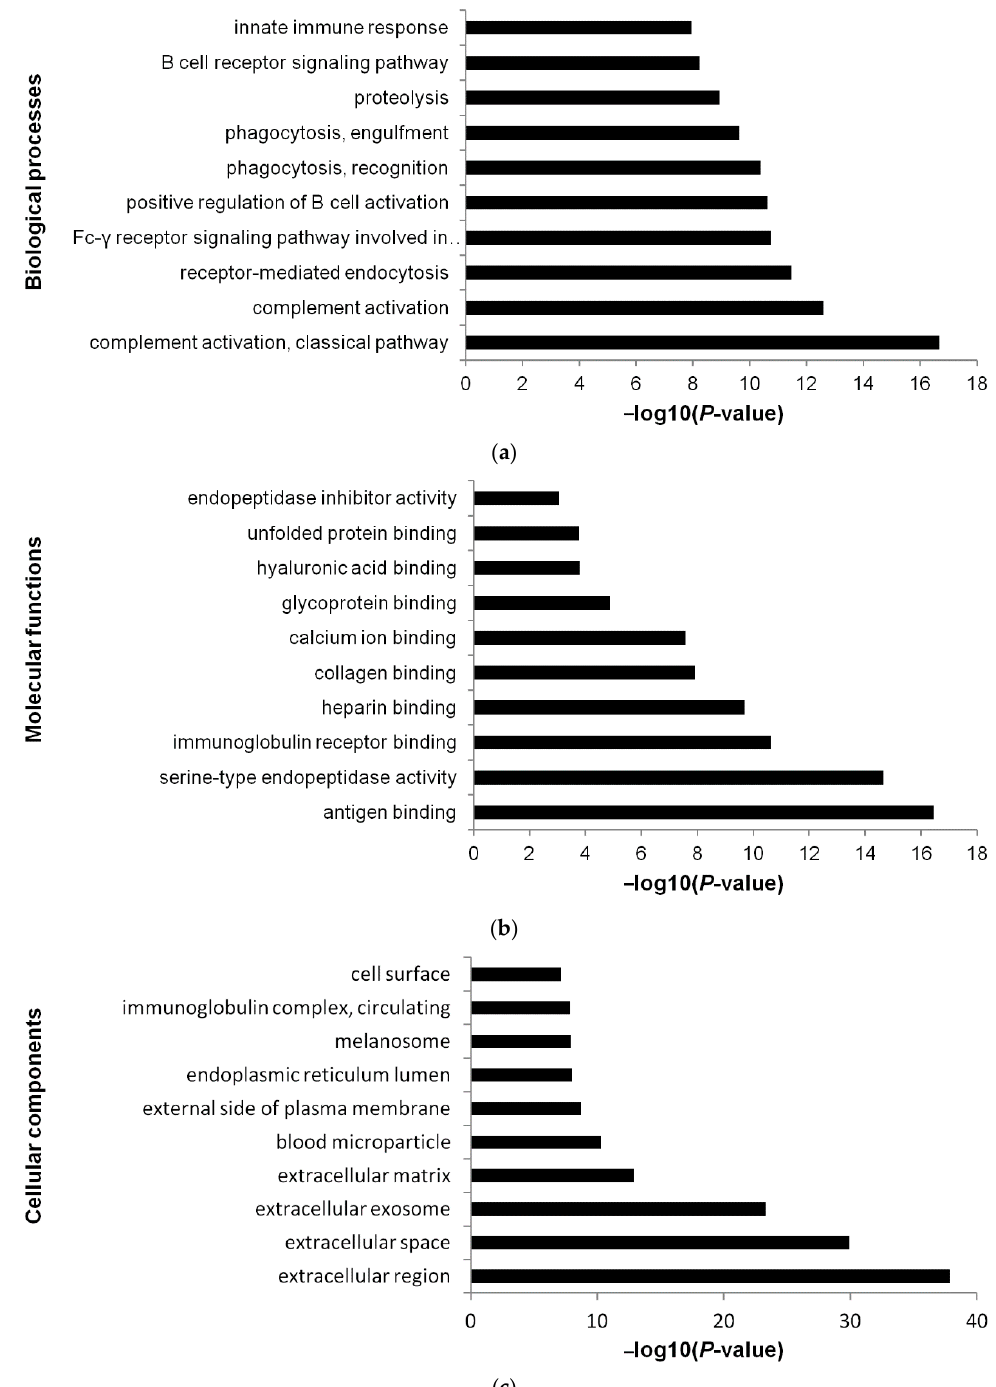
Figure 9. Top 10 most significant (Benjamini-corrected p < 0.01) biological processes ( a ), molecular functions ( b ), and cellular components ( c ) associated with plasma EV proteins of non-relapsed HL according to DAVID Bioinformatics Resources interrogated with the proteins identified LC–MS/MS after eliminating the proteins reported as detected in plasma exosomes of healthy donors (Supplementary Table S3b).